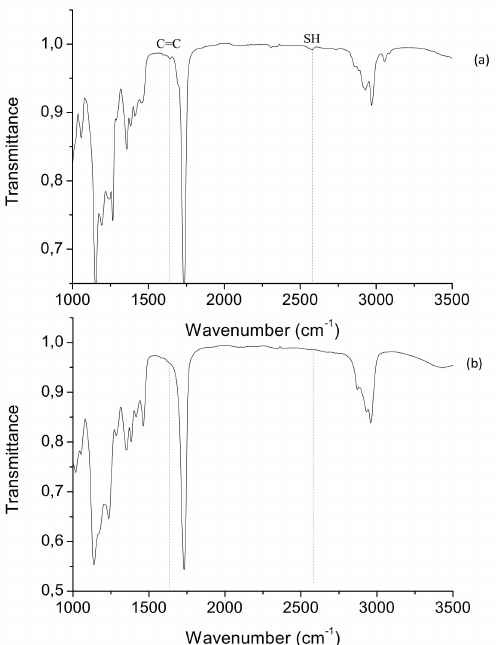
Figure 4. FTIR spectra of ( a ) 0–100 PHBHV–linalool with TriSH in the presence of DMPA before irradiation and ( b ) after